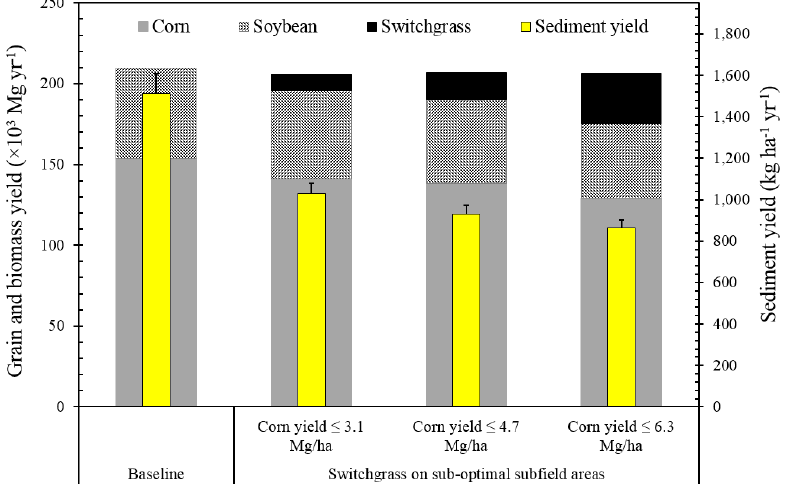
Figure 4. Grain and biomass yields (corn, soybean, and switchgrass biomass) for the baseline (current land use and land cover) and three suboptimal corn yield productivity scenarios of less or equal to 3.1 Mg·ha −1 , 4.7 Mg·ha −1 , and 6.3 Mg·ha −1 . The error bars are standard errors.